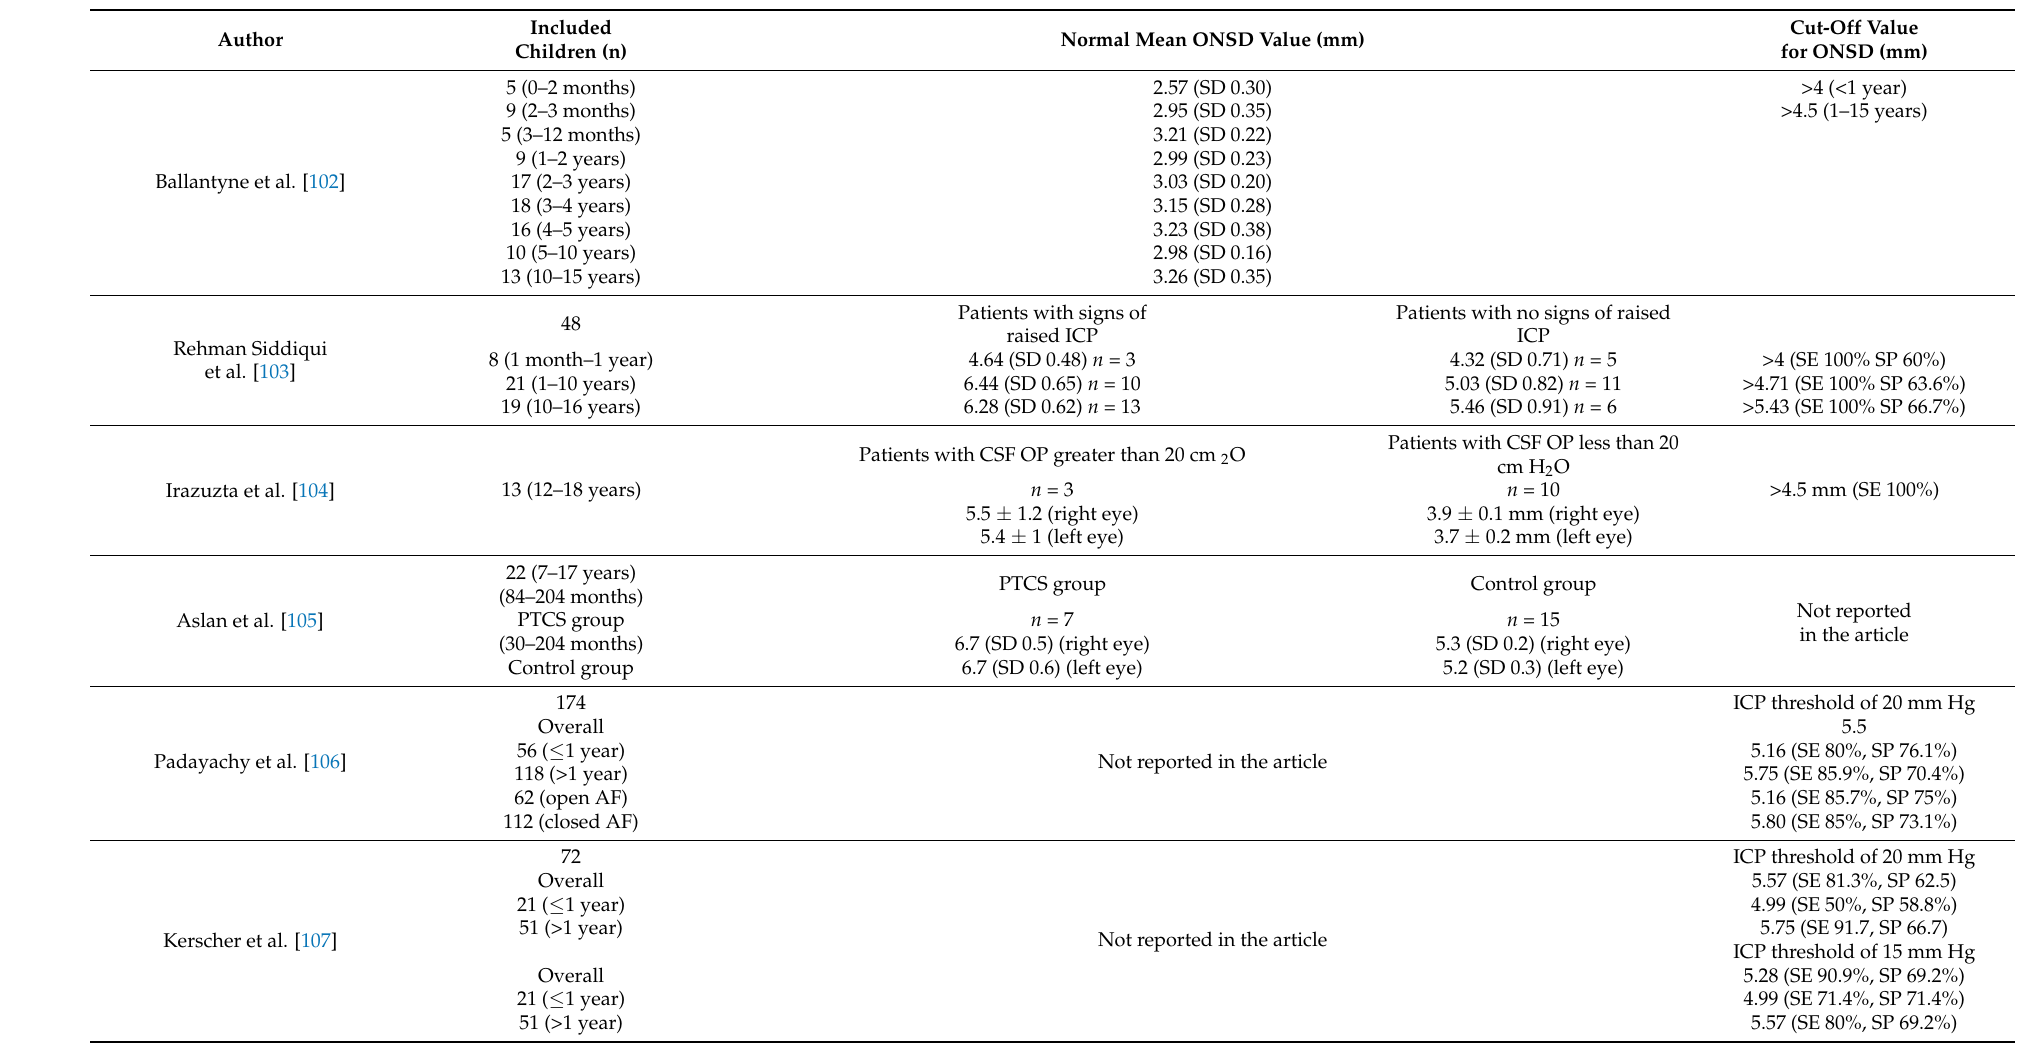
Table 2. ONSD values in the pediatric population: study